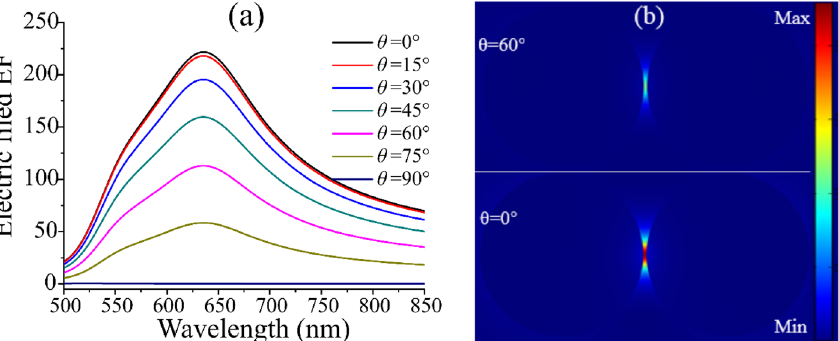
Figure 2. ( a ) The influence of the angle of incident light on the surface enhanced local electric field of Au dimer. Here we set d = 2 nm, r = 50 nm. ( b ) The electric field distribution at θ = 60° and θ = 0° with the excitation wavelength of 635 nm. The two electric field distributions are drawn on the same